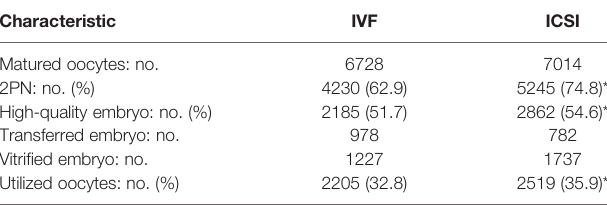
TABLE 2 | Embryo outcome of the total 1130 half-ICSI patients.